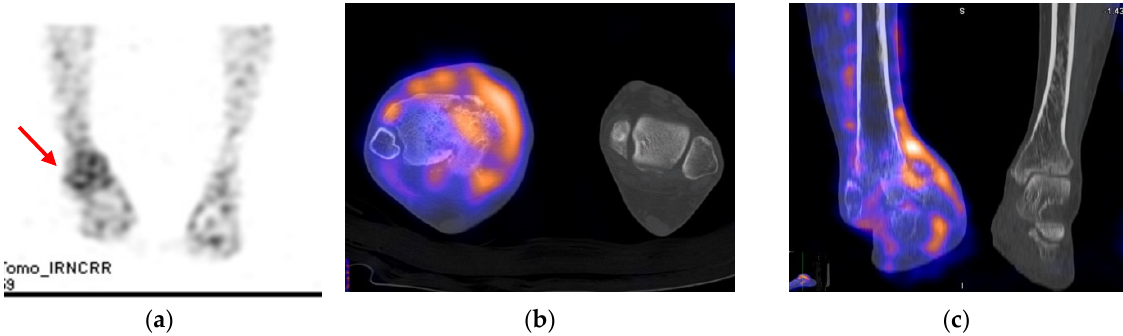
Figure 5. Hybrid 99mTc WBC SPECT/CT images showing increased uptake along the soft tissue around the ankle joint, as